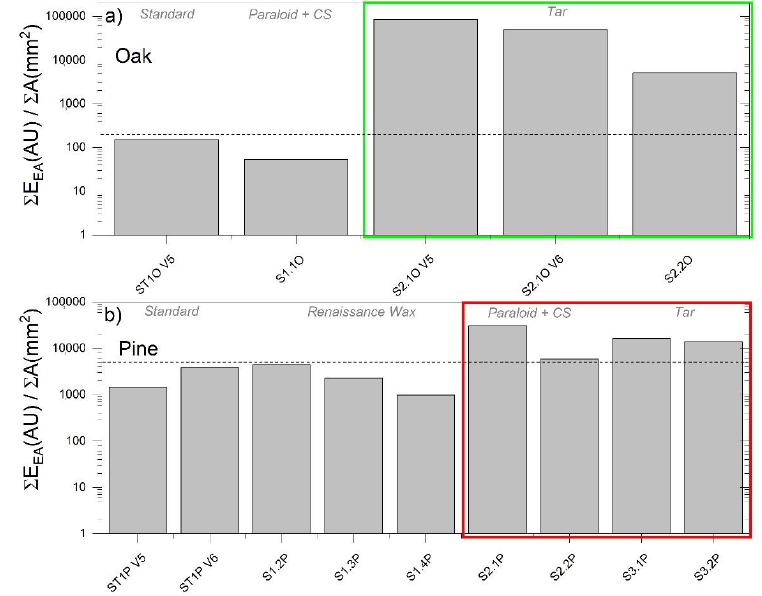
Figure 10. Total DSV (i.e., the ratio between the sum of AE energy (Σ E AE ) over the maximum fractured area ( Σ A )) for the tested samples. ( a ) From left to right, standard, CS + Paraloid and tar oak samples; ( b ) From left to right, standard, Renaissance wax, CS + Paraloid, and tar pine samples. Green boxes, samples subjected to high constraint (HC) by tar coating and red boxes, samples that showed macro damage during a previous acclimatization period.